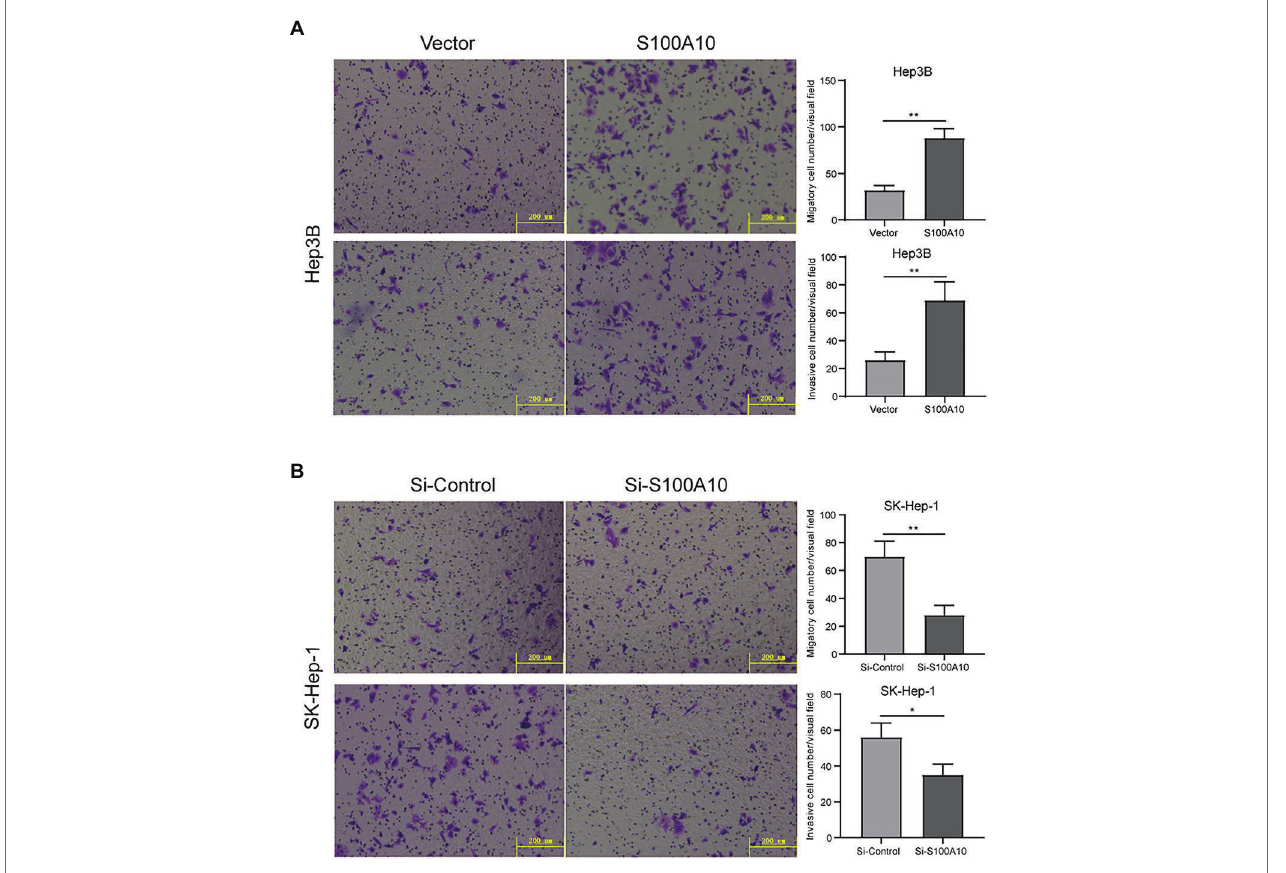
FIGURE 4 | S100 calcium binding protein A10 promoted cell migration and invasion. (A) Overexpressing S100A10 enhanced the migration and invasion of Hep3B cells. (B) Knocked S100A10 reduced the migration and invasion of SK-Hep-1 cells. * p < 0.05; ** p <